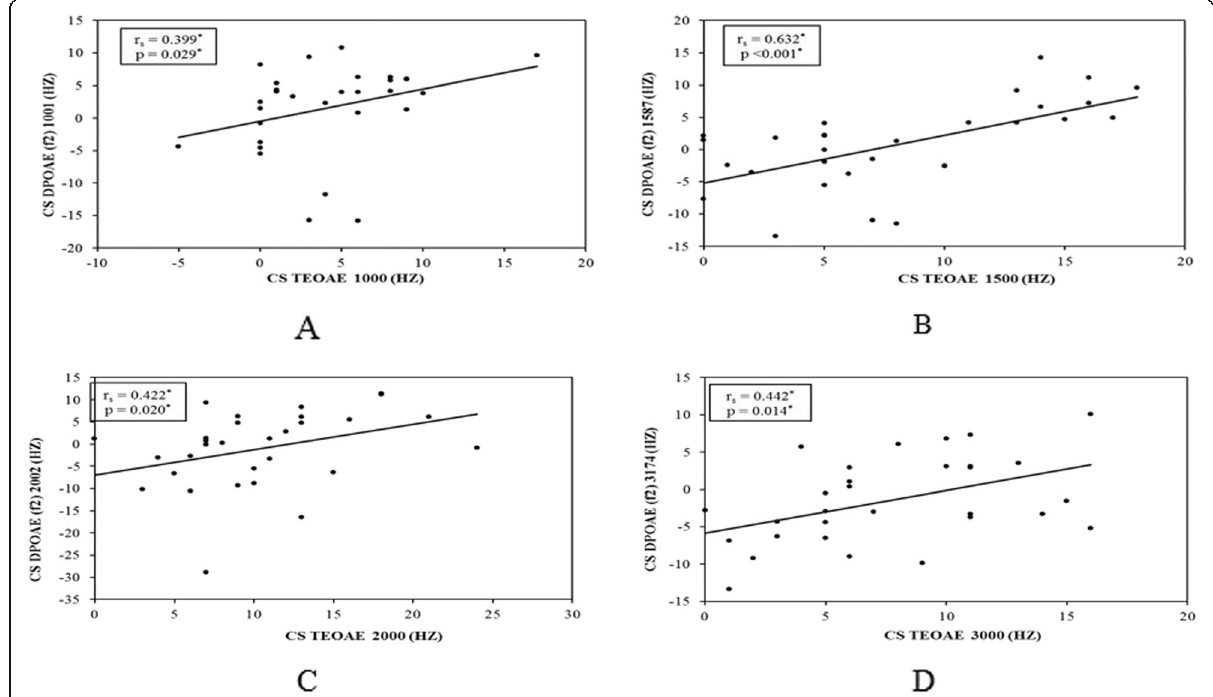
Fig. 3 Correlation between CS TEOAE amplitudes and CS DPOAE (f2) amplitudes in cases group ( n = 15, ears = 30) in 1000, 1500, 2000, and